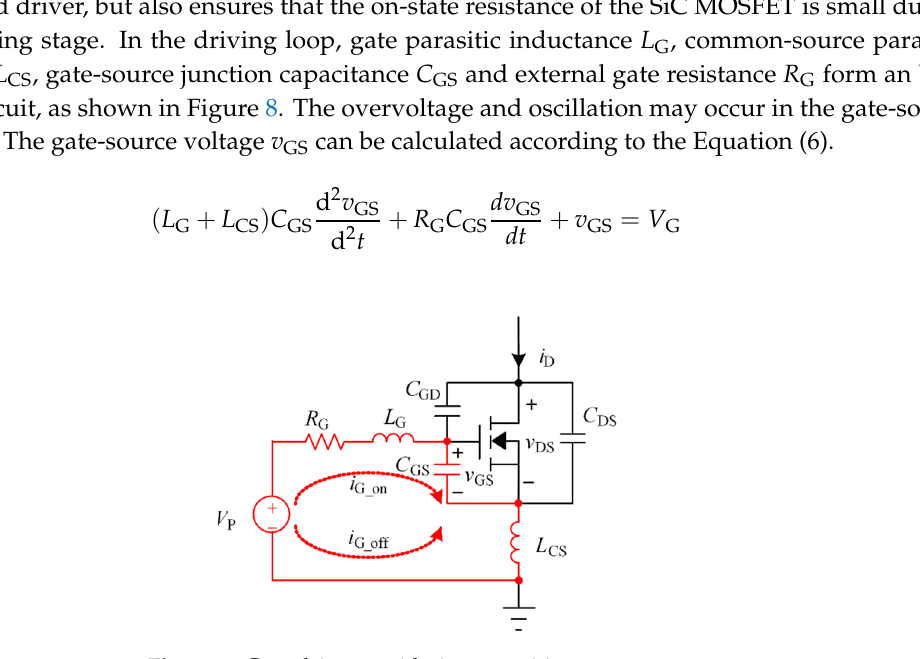
Figure 7. Double-pulse test platform based on the proposed gate driver.